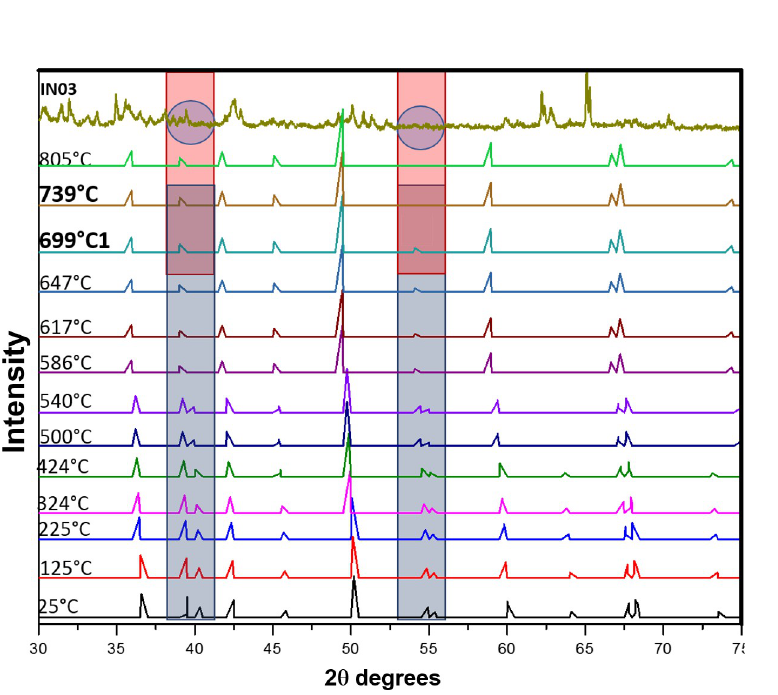
Fig 11. Comparison of the IN03 diffraction patterns with quartz at different temperatures [43]. The similarities in the colored areas revealed in the overlap of colors (rectangular and circular) allow us to estimate the firing temperature of the IN03 figurine between 699˚C and